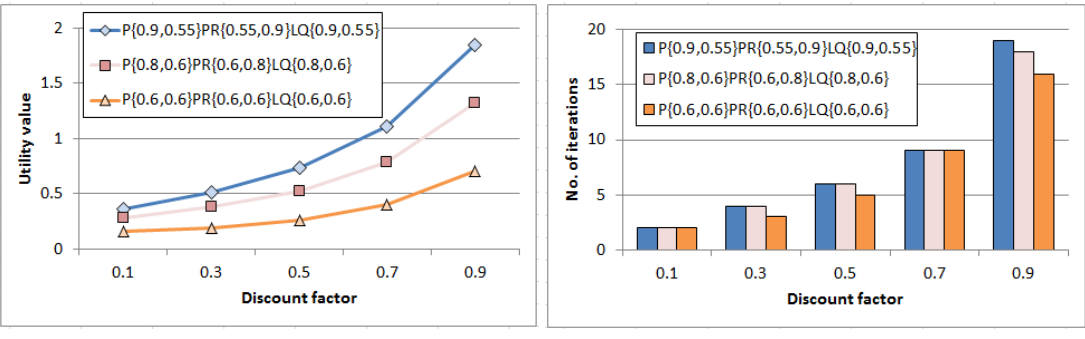
Figure 5. Performance of MDP with varying discount factor for different combinations of probability values related to event generation P ( p on , p of f ), PR ( pr on , pr of f ) and link quality LQ ( lq on , lq of f